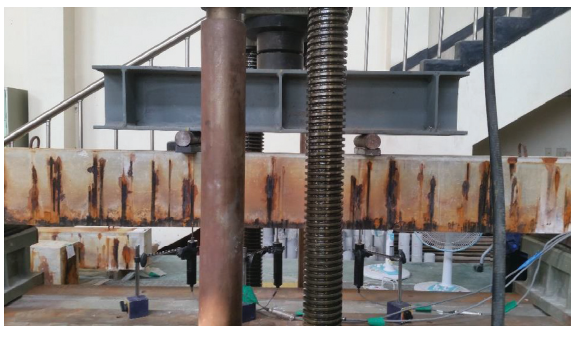
Figure 7: Test setup. Table 1: Average potential difference in voltage (unit: mV CSE). Type